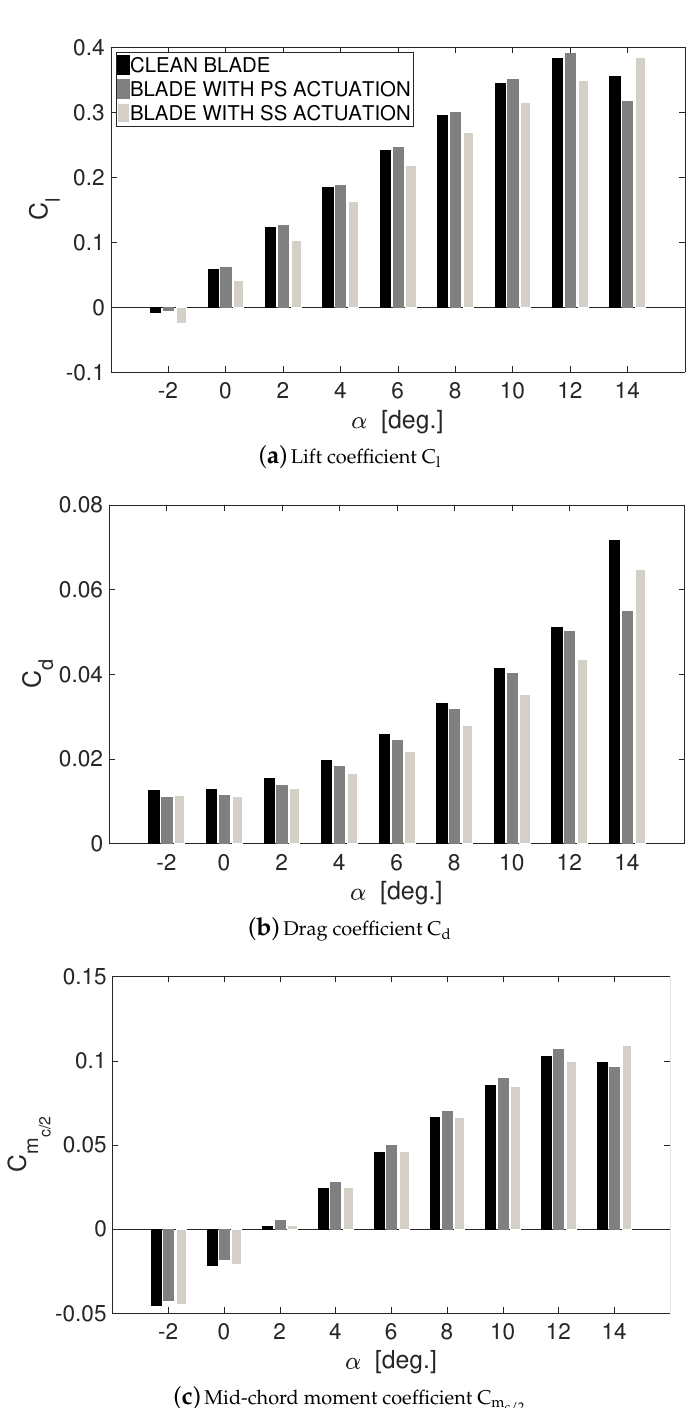
Figure 10. Lift, drag and mid-chord moment coefficient on the clean blade and with PS/SS actuation; Re ∼ 350,000; α ∈ [ 0 12 ]